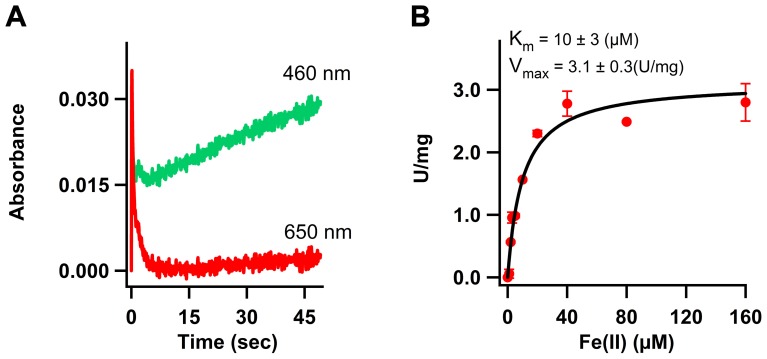
Use of transferrin to measure the ferroxidase activity of ferritin and ceruloplasmin.(A) Effect of transferrin on Fe(II) oxidation by human H-chain ferritin (HuHF) measured at 650 nm for formation and decay of the blue intermediate, and at 460 nm for formation of diferric transferrin complex. Concentration of apo-HuHF was 1.7 µM (24-mer) and that of transferrin was 70 µM. Two Fe(II) per ferroxidase center, i.e. 48 Fe(II) per 24-mer which is equal to a final concentration of 81.6 µM Fe(II), were added and measurements were done at 34°C in 400 mM Mops buffer, 100 mM NaCl, pH 7.0. (B) Ferroxidase activity of ceruloplasmin was measured using the transferrin assay at 460 nm. Progress curves were recorded and initial rate of Fe(III) formation was plotted versus concentration of Fe(II). Concentration of ceruloplasmin was 0.1 µM. Measurements were performed at 37°C in triplicate. Buffer was 100 mM Mops, 100 mM NaCl, pH 7.1.